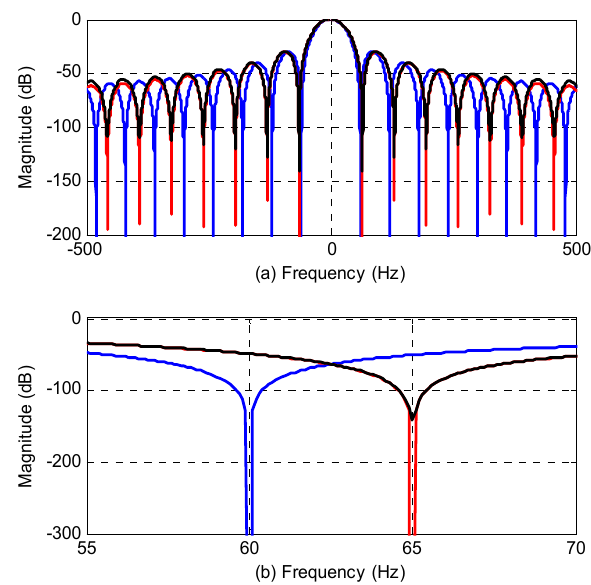
Figure 1. (a) Frequency responses of the filters, and (b) a zoomed-in view of frequency responses. (The blue line is for the non-adaptive moving average filter (NMAF), the black line is for the linear interpolation-based moving average filter (LIP-AMAF) and the red line is for the proposed fixed length adaptive moving average filter (FAMAF).).